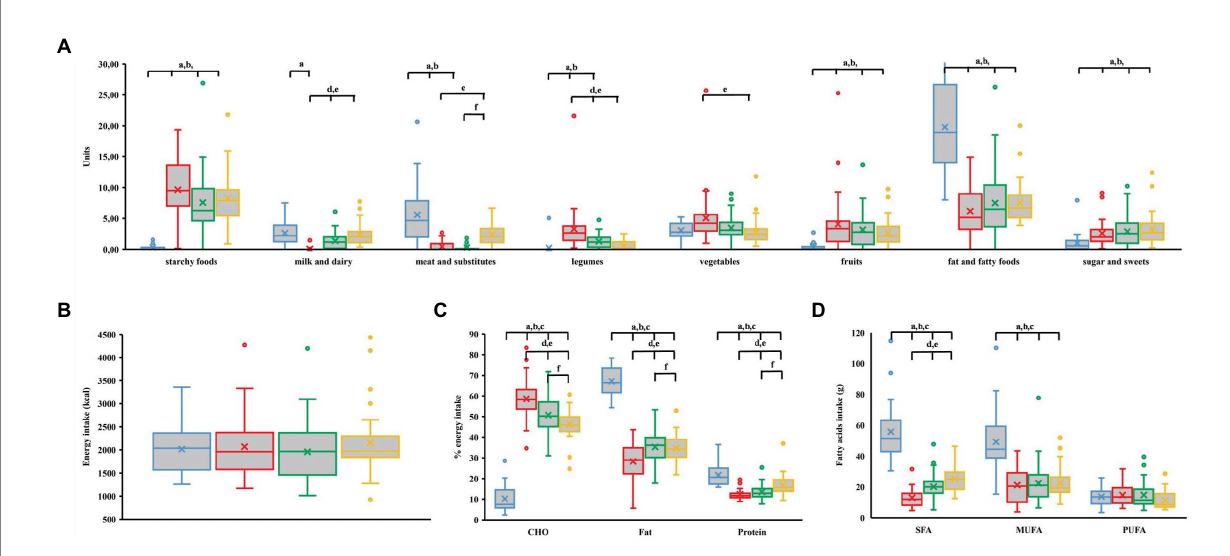
FIGURE 3 (A) Food group unit intake (meat and substitutes include vegan meat substitutes). (B) Daily energy intake. (C) Contribution of macronutrients to daily energy intake. (D) Fatty acids intake. LCHF, low carbohydrate high fat; CHO, carbohydrate; SFA, saturated fatty acids; MUFA, monounsaturated fatty acids; PUFA, polyunsaturated fatty acids. Blue—LCHF, red—Vegan, green—Vegetarian, yellow—Omnivorous. index p < 0.05, Student’s or Mann–Whitney test between: a LCHF and vegan group; b LCHF and vegetarian group; c LCHF and omnivorous group; d vegan and vegetarian group; e vegan and omnivorous group; f vegetarian and omnivorous